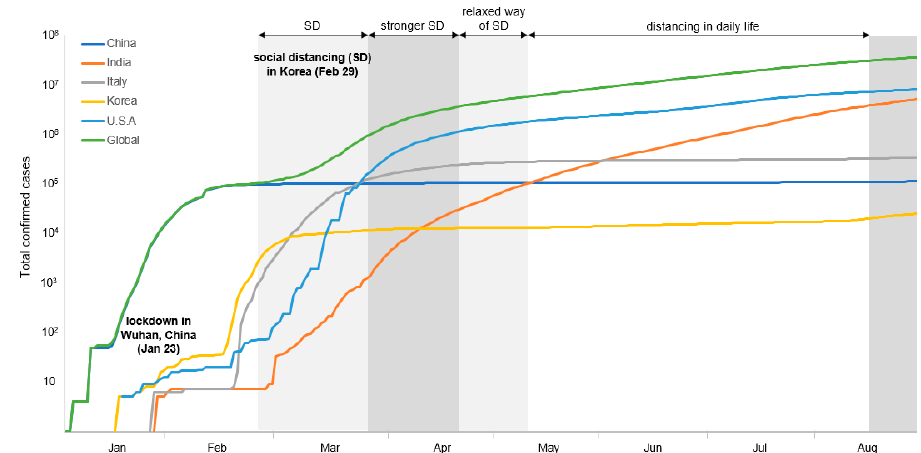
Figure 1. The cumulative number of COVID-19 cases worldwide. The highlighted shadow represents the level of social distancing (SD) in Korea. The data were collected from the WHO Coronavirus Disease (COVID-19) Dashboard [2].